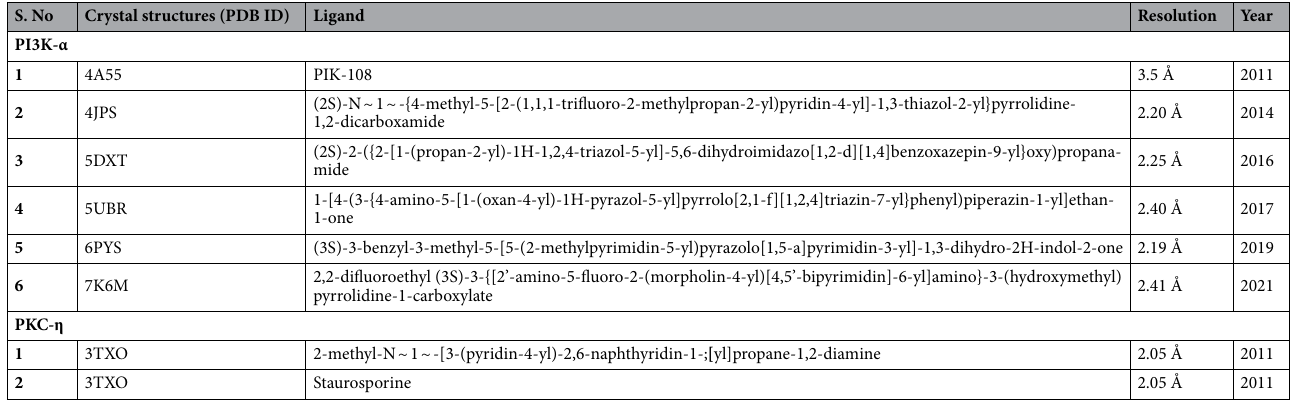
Table 1. Crystal structures of PI3K-α and PKC-η co-crystalized with different ligands were downloaded from